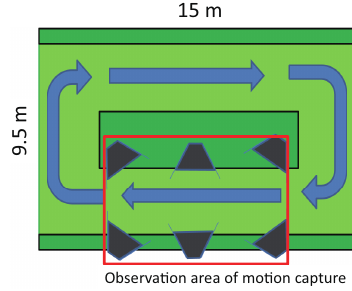
Figure 2: Experimental environment